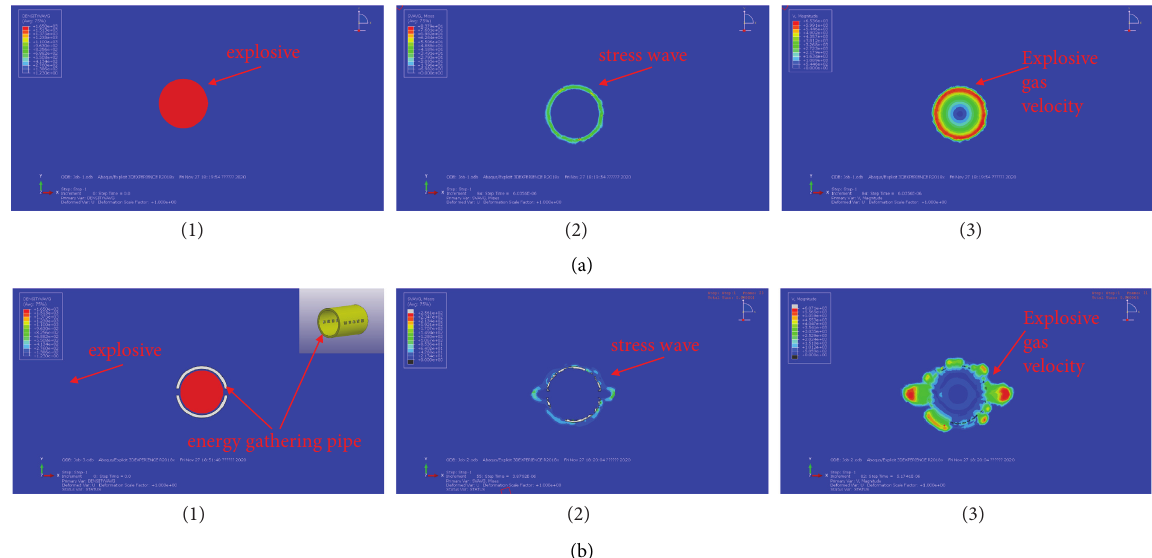
Figure 5: Simulation of explosive blasting in the air: (a) without adding energy gathering pipe and (b) by adding energy gathering